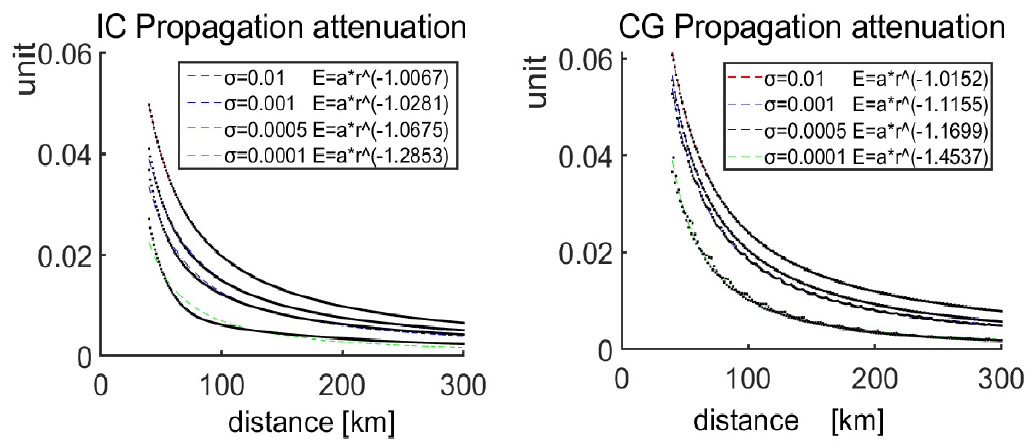
Figure 12. Variations in IC and CG peak values with distance obtained from the simulation.